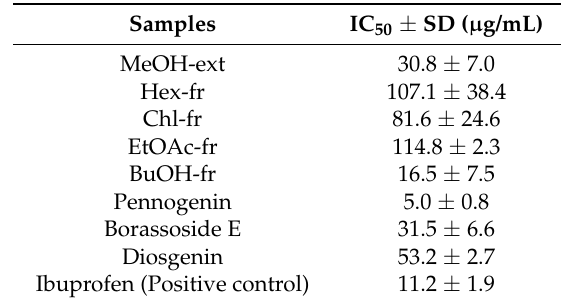
Table 4. Inhibitory effect on release of ROS by Trillium govanianum methanol extract, fractions and isolated